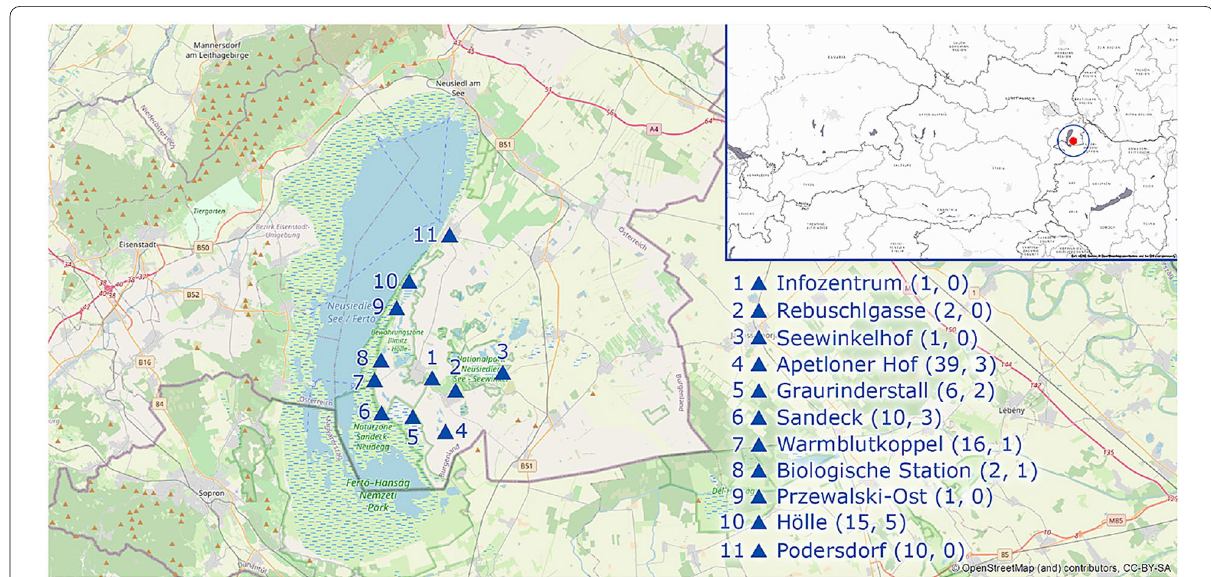
Fig. 1 Sample locations in the study area at the East of the Neusiedler See (in the East of Austria, at the Hungarian border). Blue triangles show the sampling locations. At the right lower corner, the associated names and sample numbers (in parenthesis) are shown (first number in parenthesis: total number of samples, second number: number of samples with P. fuscus